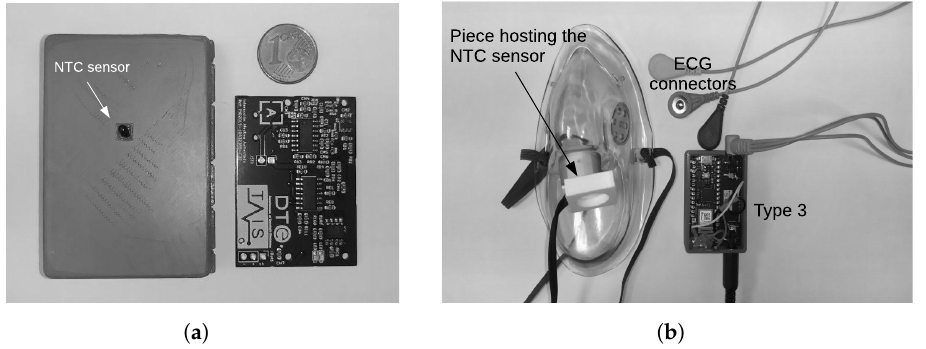
Figure 2. Samples of 2 of our proposed wearable designs. ( a ) Device that records the EDA and the ST signals (Type 2). This is a bottom view and the printed circuit board; ( b ) the circuit board for ECG and BR measurements (Type 3). The ECG connectors, the face mask and the piece hosting the temperature sensor for air flow detection are also shown.